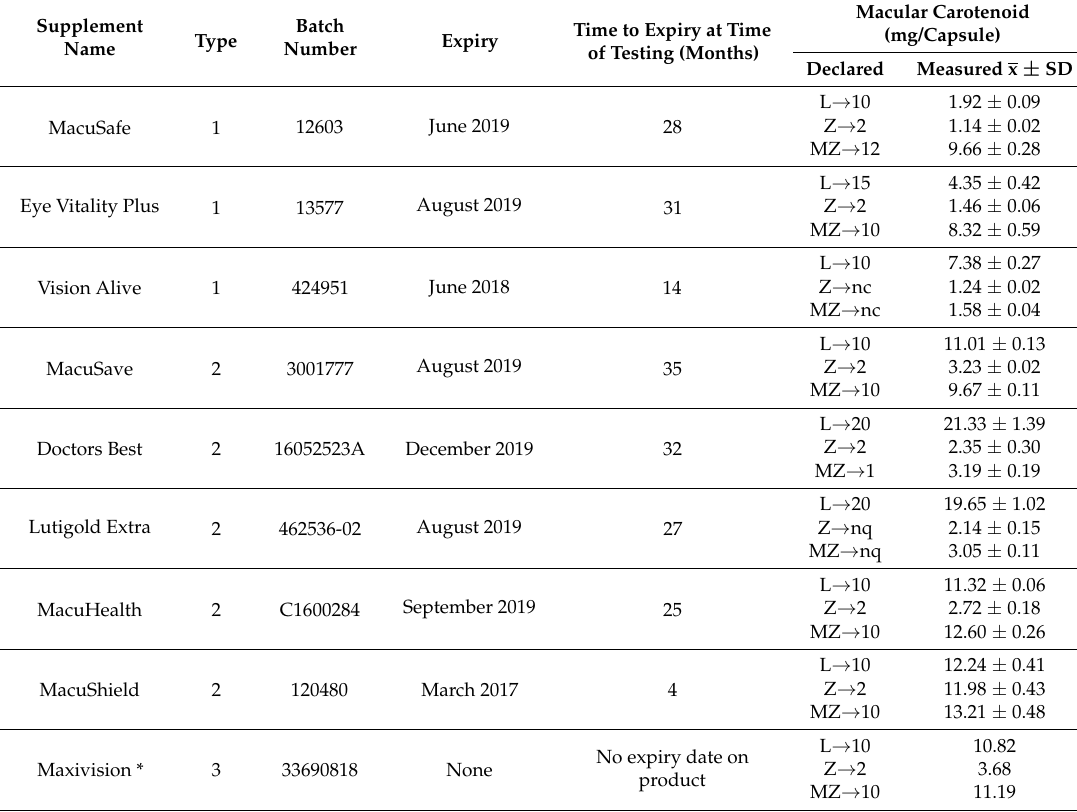
Table 1. Macular carotenoid concentration of the commercially available supplements